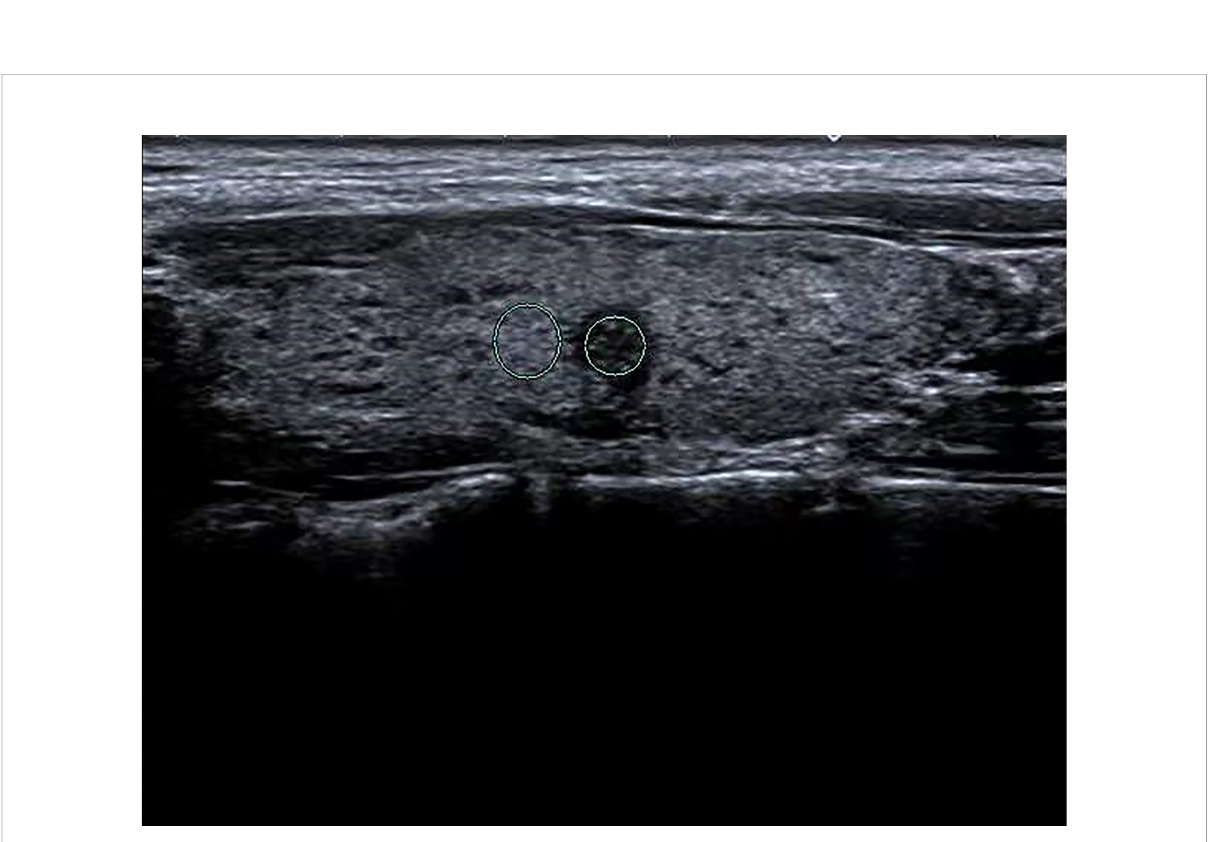
FIGURE 6 Female patient, 33 years old, half-month case history of a thyroid nodule, pathology con fi rmed as PTMC with HT. TG-Ab = 278 kU/L, TPO-Ab = 600 kU/L, UGSR = 30.04/85.33 = 0.352 (medical center B).